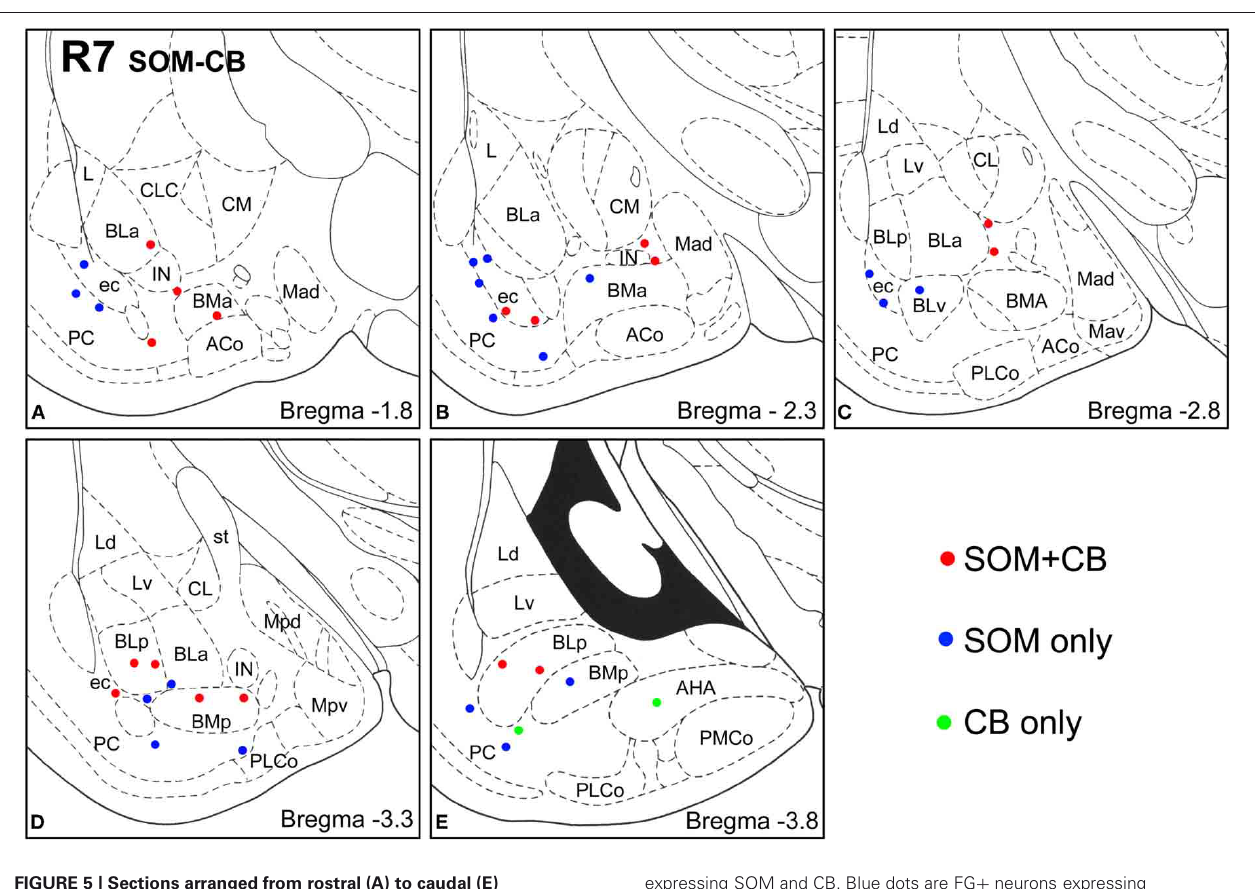
FIGURE 5 | Sections arranged from rostral (A) to caudal (E) depicting the locations of long-range non-pyramidal neurons in the amygdalar region expressing SOM and/or CB in case R7. Each dot represents one neuron. Red dots are FG + neurons